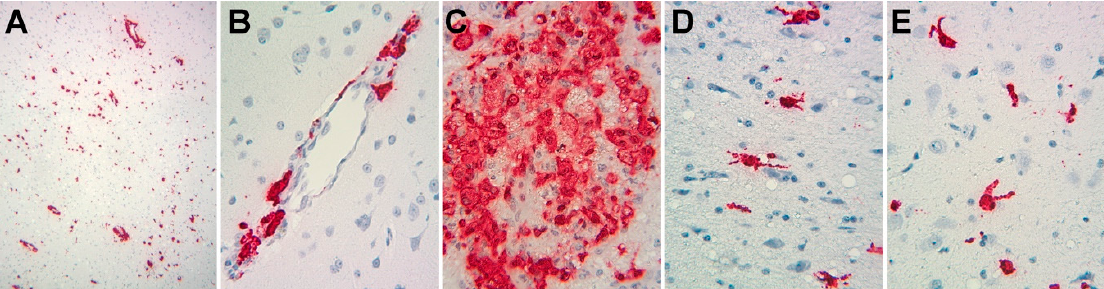
Figure 1. Photomicrographs of in situ hybridization study of SIV RNA expression in the brains of animals from this study. Signals representing SIV RNA are red, nuclei counterstained with hematoxylin are blue. ( A ) Low power (original magnification 100 × ) from animal 17T, revealing abundant expression. ( B – E ) Medium power (original magnification 200 × ) revealing cells with the morphological appearance of perivascular macrophages ( B , from animal 21T), macrophage clusters ( C , from animal 32T), and cells with the morphological appearance of activated microglia ( D , E , from animal 34T).